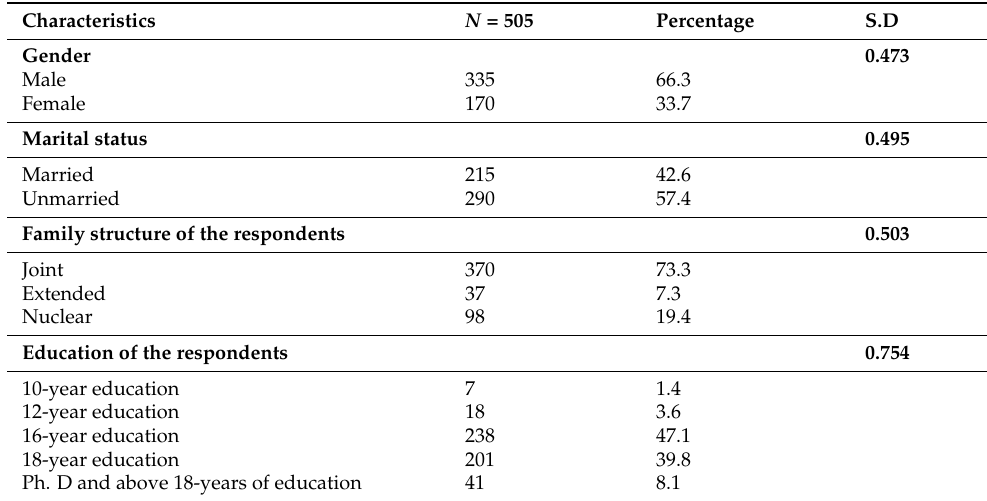
Table 1. Demographic Characteristic of the Respondents.